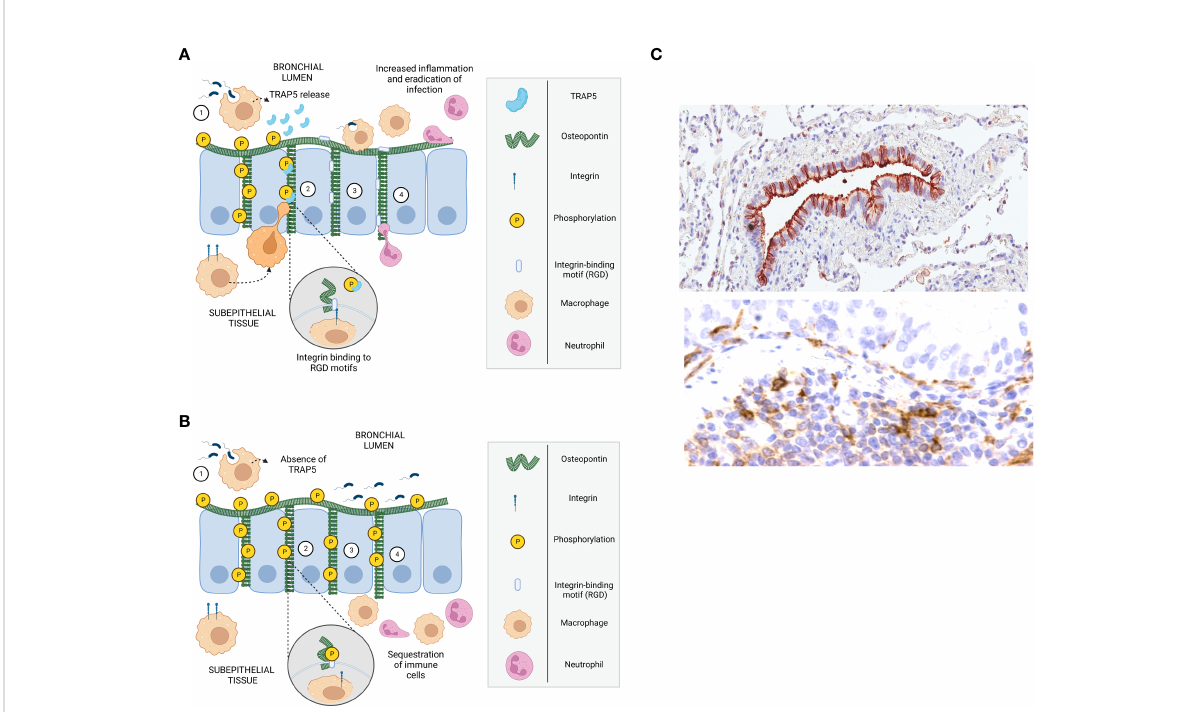
FIGURE 7 Mechanism describing TRAP5/OPN-dependent recruitment of immune cells to the airways. (A, B) Schematic drawings of mechanism describing immune cell recruitment, with (A) describing the development of in fl ammation in infected wild-type mice and (B) in Trap5-/- mice. 1. Residential alveolar macrophages detect bacteria through pathogen recognition receptors (TLRs) and become activated, stimulating epithelial cells that in turn secrete cytokines/chemokines, attracting neutrophils and macrophages. 2. TRAP5 released (absent in Trap5-/- mice) by activated alveolar macrophages dephosphorylates osteopontin (OPN) exposing integrin-binding motifs (i.e. regions containing RGD and RGD- like sequences). 3. Immune cells (e.g. in fl ammatory macrophages and neutrophils) migrate into the bronchial lumen in a haptotactic manner. The migration of immune cells is dependent on their integrins binding to the RGD-motifs of OPN, which is affected by the phosphorylation status of OPN (as shown inset). In the absence of TRAP5 (as seen in Trap5-/- mice), OPN remains phosphorylated and immune cells accumulate in the subepithelial tissue. 4. Recruited immune cells further amplify in fl ammation by release of cytokines/chemokines attracting more immune cells to the lumen to clear bacterial infections. (C) OPN staining in human lung tissue shown in the top fi gure (brown), where it is localized on the apical surface as well as in the intercellular space between the bronchial epithelial cells of a small airway. TRAP5 and released TRAP5 detected in macrophages of subepithelial tissue of the airways (bottom